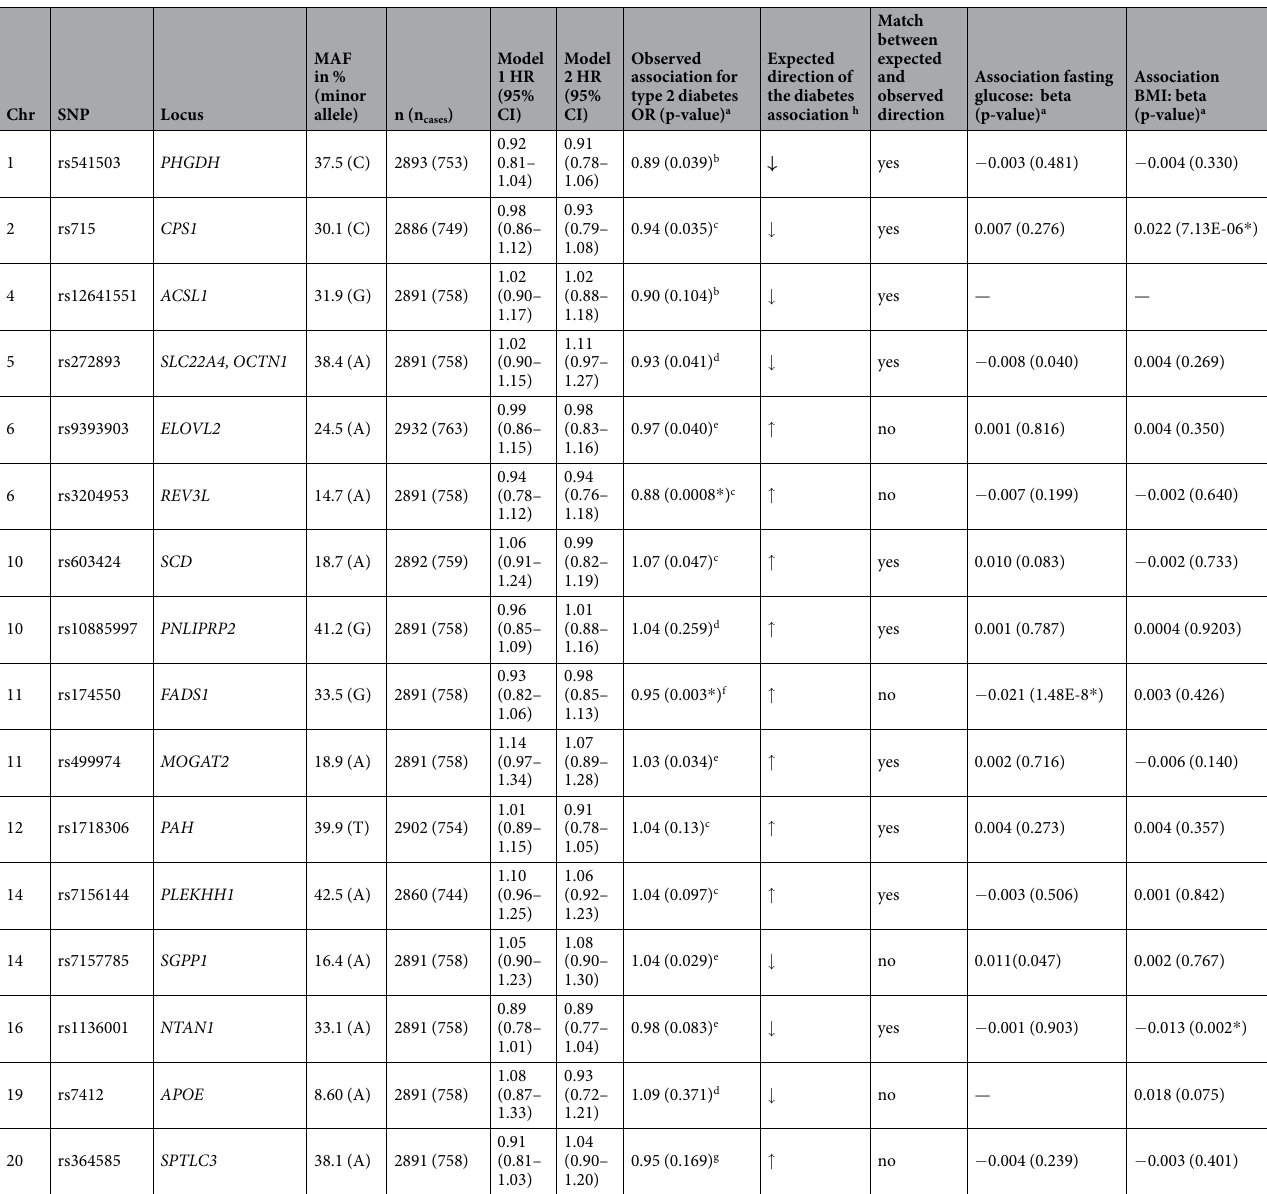
Table 3. HRs (95% CI) for type 2 diabetes of genetic variants in EPIC-Potsdam and look-up in other consortia for type 2 diabetes, fasting glucose and BMI. SNP, single nucleotide polymorphism; Chr, chromosome; MAF, minor allele frequency; HR, hazard ratio; CI, confidence interval; OR, odds ratio. Only genetic variants which could be replicated within KORA F4 were included. Model 1 is stratified for age at baseline and adjusted for sex; Model 2 is further adjusted for waist circumference. a Results for type 2 diabetes were looked up at http://www. type2diabetesgenetics.org on the 21.07.2016 14 ; beta estimates for fasting glucose are from MAGIC GWAS data 15 ; beta estimates for BMI are from GIANT GWAS data 16 , strongest type 2 diabetes association reported within: b GoT2D WGS, c GoT2D WGS + replication, d GWAS SIGMA, e DIAGRAM, f 82k exome chip, g SIGMA exome chip analysis. h Expected direction was defined based on the sign of the product between the SNP-metabolite trait association and the metabolite trait-type 2 diabetes association (using cox-regression models adjusted for age and sex); ↑ Indicates a positive association, ↓ Indicates an inverse association. * Significant after correction for false discovery rate 62